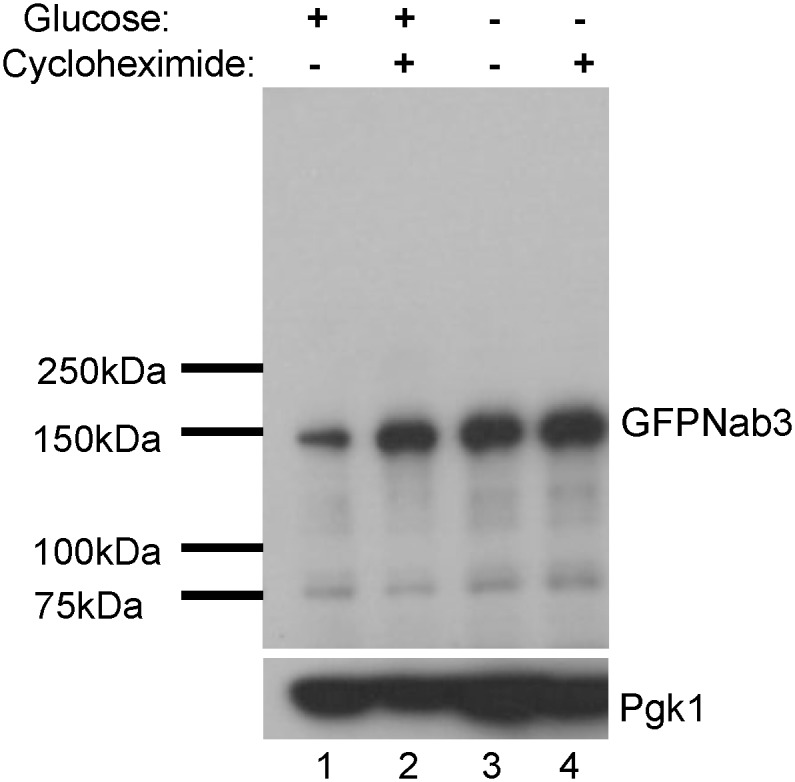
Nab3 levels persist during starvation.To assess the stability of Nab3 under the varying growth conditions, water or cycloheximide (125 μM,) were added as indicated to logarithmically growing DY32309 cells grown in glucose-containing media (lanes 1 and 2). Cells grown in the absence of drug and presence of glucose were washed into glucose-free media, split in two, and one starved culture was treated with cycloheximide for 2 hrs (lanes 3 and 4). Cells were lysed by boiling in electrophoresis sample buffer, subjected to SDS-PAGE, and western blotted using an anti-Nab3 monoclonal antibody as described in Materials and Methods. The filter was stripped and reprobed with anti-Pgk1 as a loading reference.